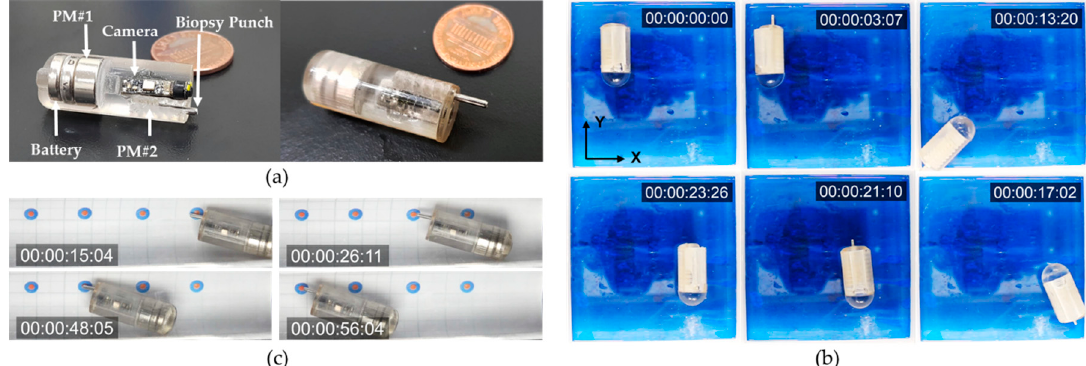
Figure 6. ( a ) Components of the active capsule endoscope (ACE) and biopsy module. ( b ) Needle control and locomotion experiments in a large space with small friction in chronological sequence. ( c ) Targeting experiment for the given markers on the phantom. A real-time watch was added, which shows the time in the format hour:min:sec:msec.